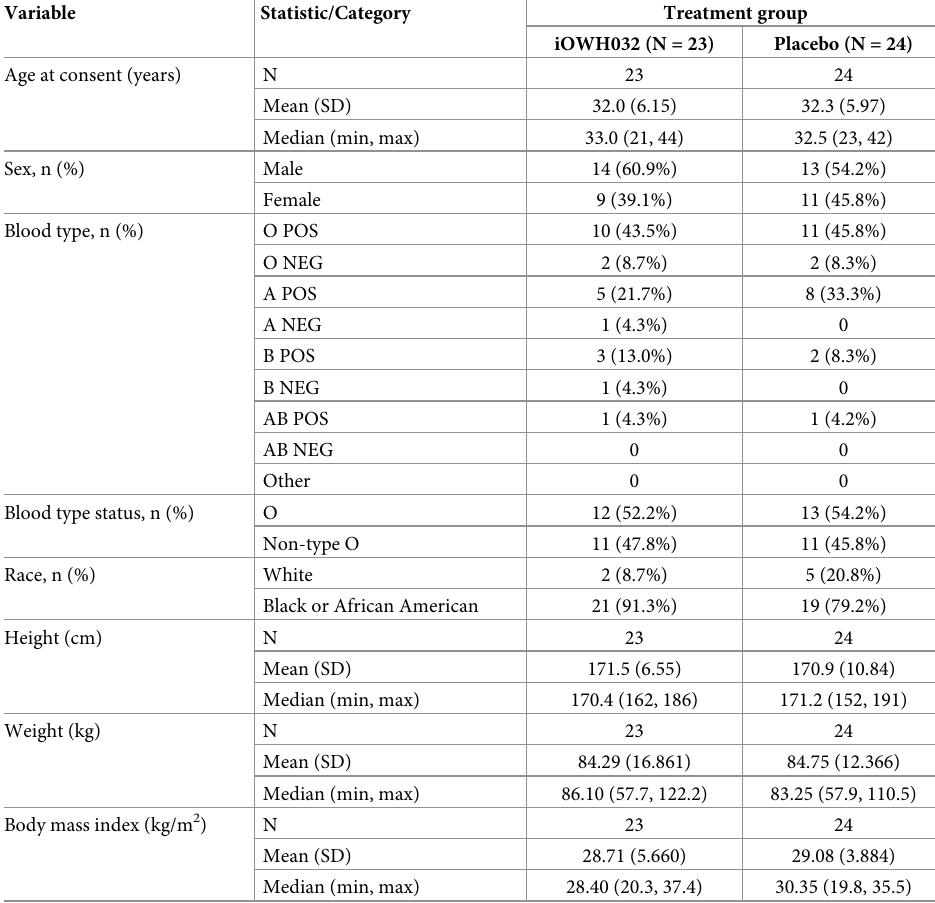
Table 2. Demographics and baseline characteristics of the safety population.